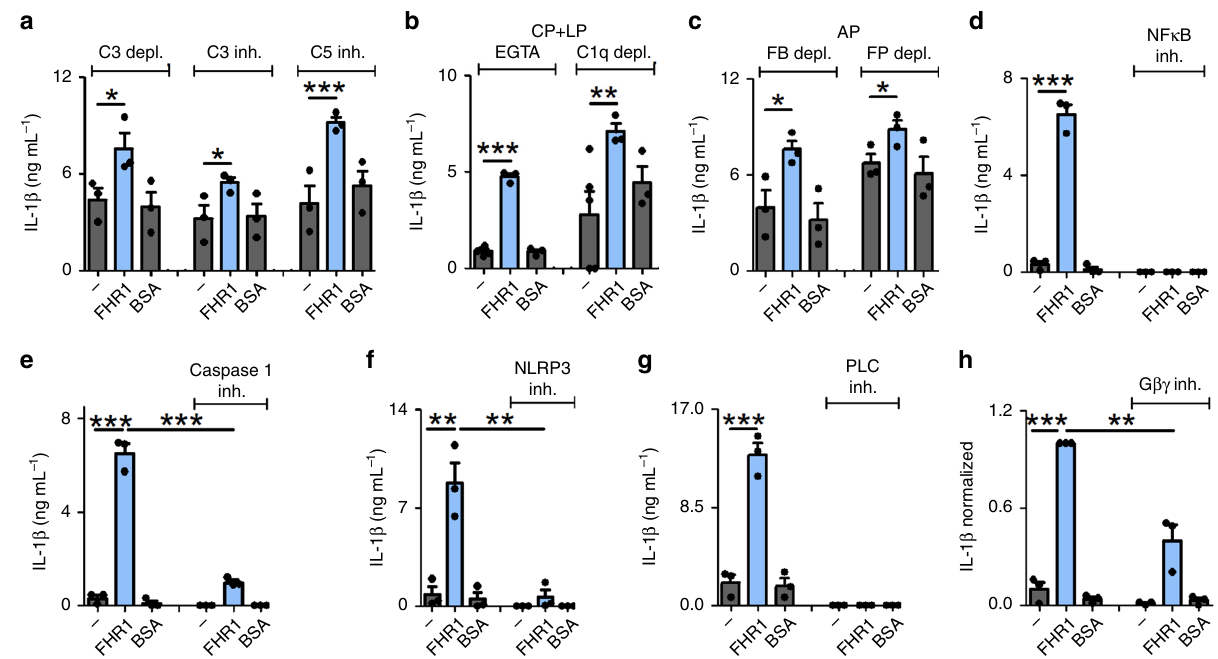
Fig. 3 FHR1 activates NLRP3 in monocytes via the PLC pathway. a Immobilized FHR1 increases secretion of IL-1 β in LPS-treated monocytes exposed to C3- depleted, C3-inhibited (Compstatin), or C5-inhibited (Eculizumab) NHS. b FHR1 stimulates secretion of IL-1 β by EGTA-treated or C1q-depleted NHS, which blocks the classical (CP) and lectin pathways (LP) activation, respectively, as well as in c factor B (FB)- or factor P (FP)-depleted NHS (in which the alternative pathway (AP) is inhibited). d IL-1 β induction by FHR1 is blocked when NF- κ B is inhibited by BAY 11-7085. e IL-1 β secretion is blocked by a caspase-1 inhibitor (VX-765), f by a NLRP3 inhibitor (MCC950), or g by a PLC inhibitor (U73122). h Blocking G βγ subunit of GPCRs with Gallein reduces IL-1 β induction by FHR1 by about 65% after 4 h incubation. Data in a - h represent the mean ± SEM. of three independent experiments with cells